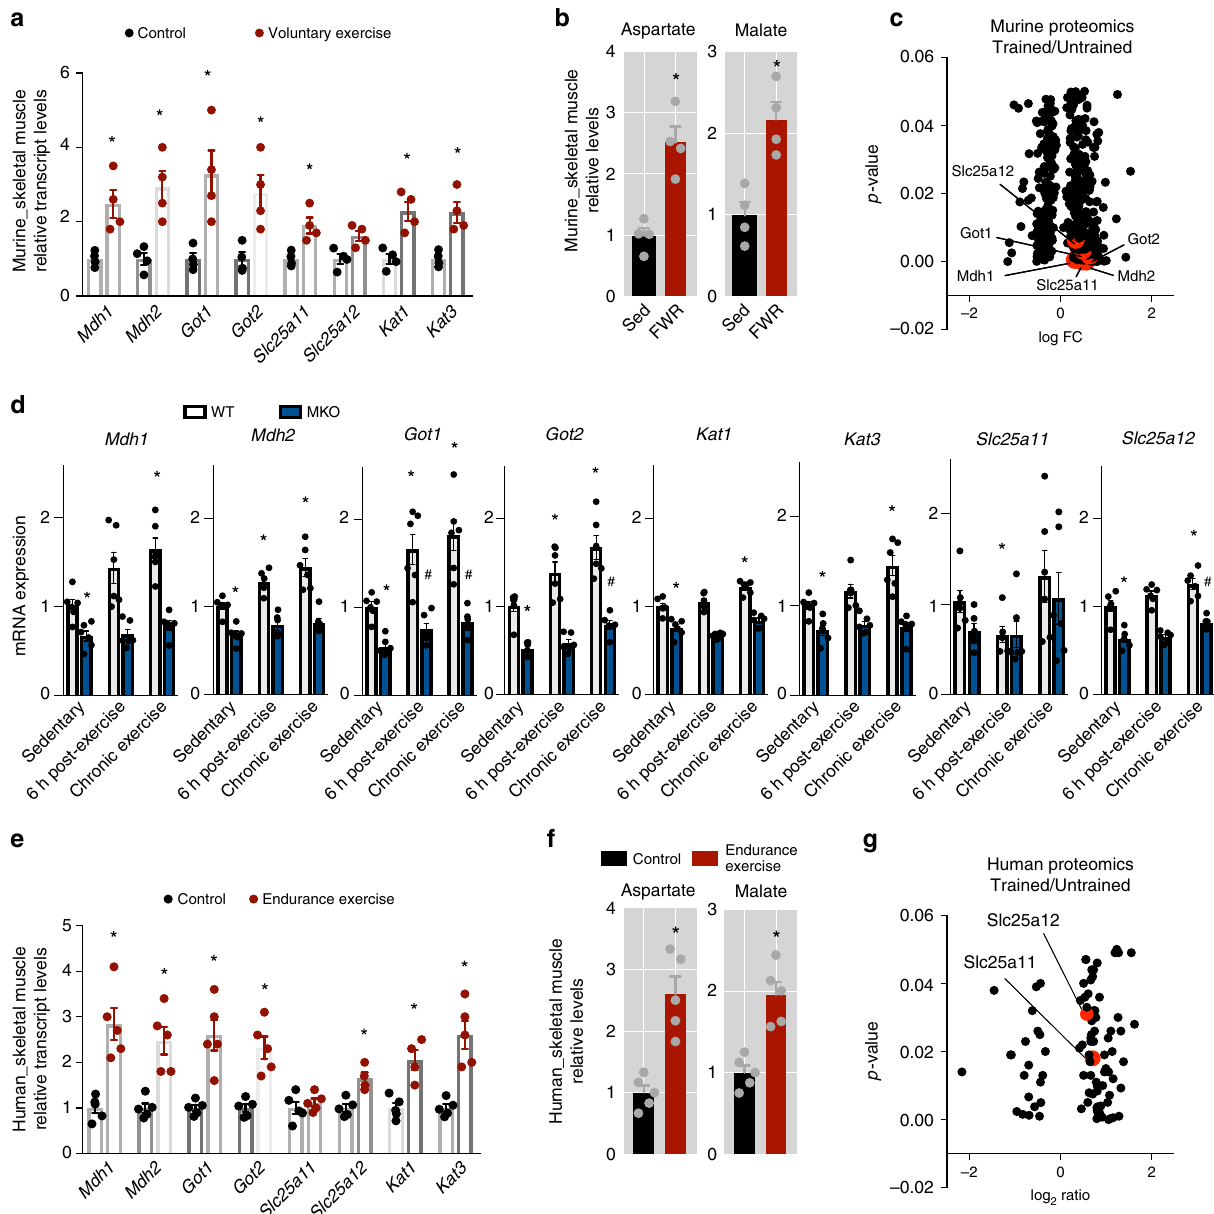
Fig. 5 Endurance exercise effects in both murine and human skeletal muscle. a Relative transcript levels of genes involved in malate-aspartate metabolism in skeletal muscle of sedentary wild-type mice and wild-type mice with access to free-wheel running (FWR) for 8 weeks. Mice were sacri fi ced 12 h after the last bout of exercise ( n = 4). b Relative levels of aspartate and malate in skeletal muscle of sedentary and wild-type mice with access to FWR ( n = 4). c Compared proteomics from skeletal muscle of trained and untrained mice 15 . d Relative transcript levels of genes involved in malate-aspartate metabolism in skeletal muscle of sedentary, acutely and chronically exercised wt and MKO-PGC-1 α mice ( n = 5 – 6). e Expression of genes involved in malate-aspartate metabolism in skeletal muscle of human volunteers after endurance exercised ( n = 5). f Relative levels of aspartate and malate in skeletal muscle of human volunteers after endurance exercise ( n = 5). g Compared proteomics from skeletal muscle of human volunteers after endurance exercise 17,23,24 . Bars depict mean values and error bars indicate SEM. Unpaired, two-tailed student ’ s t -test was used when two groups were compared, and one-way analysis of variance (ANOVA) followed by Fisher ’ s least signi fi cance difference (LSD) test for post hoc comparisons were used to compare multiple groups, * p <